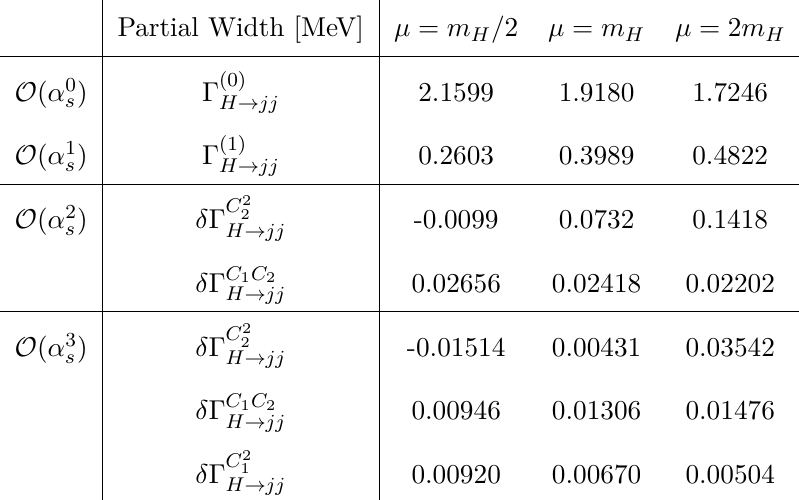
) and O ( α 3 ) . s s 1 , 2 , 5